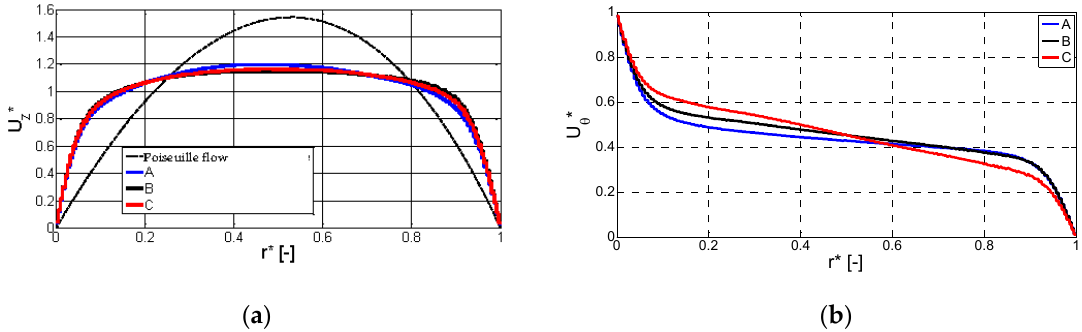
Figure 8. Velocity profiles of the streamwise ( a ) and spanwise ( b ) components obtained by the LES OneEqEddy model of OpenFOAM.